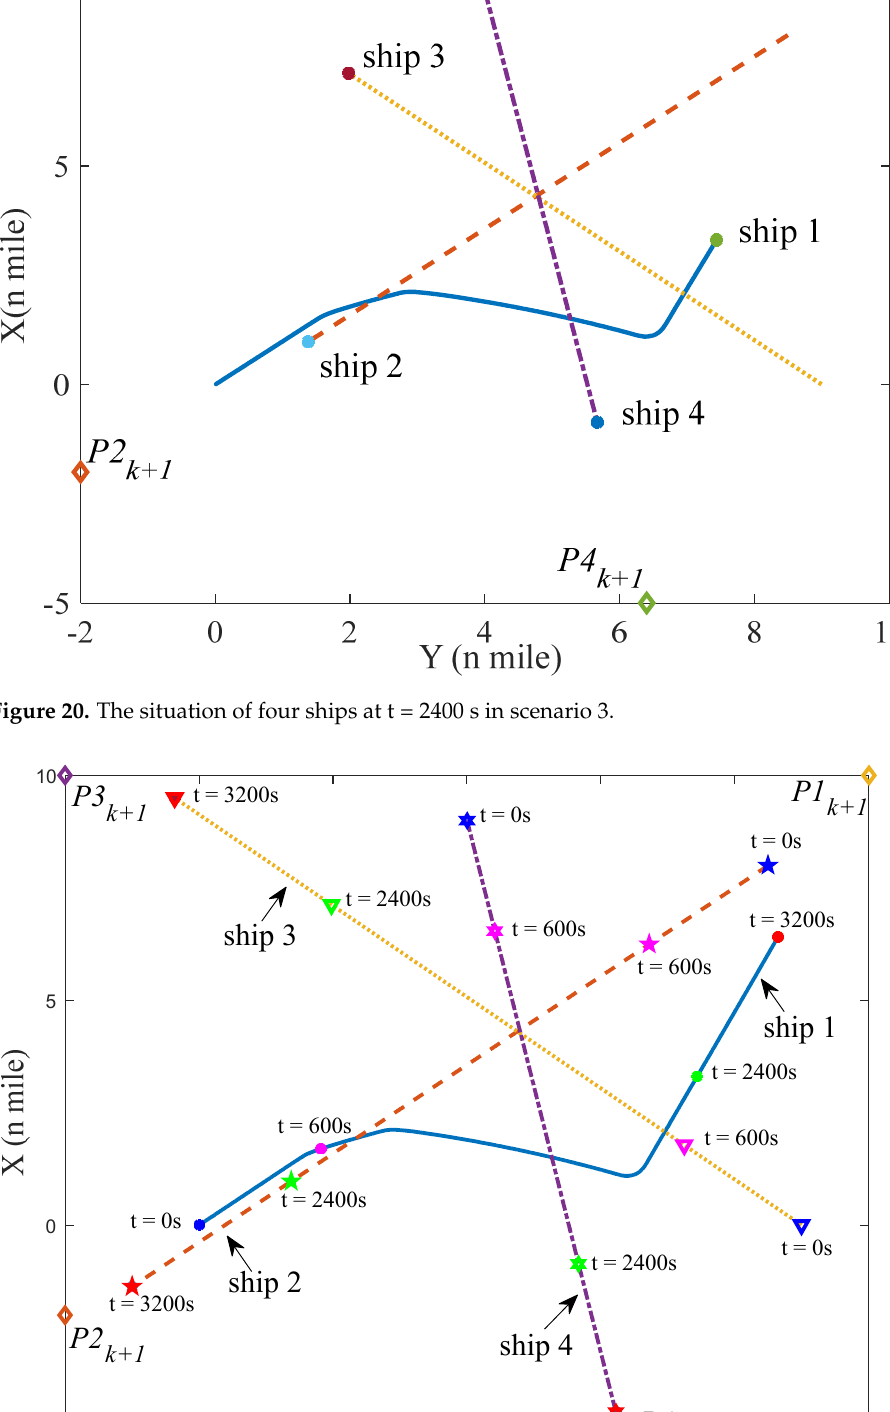
Figure 19. The situation of four ships at t = 600 s in scenario 3.